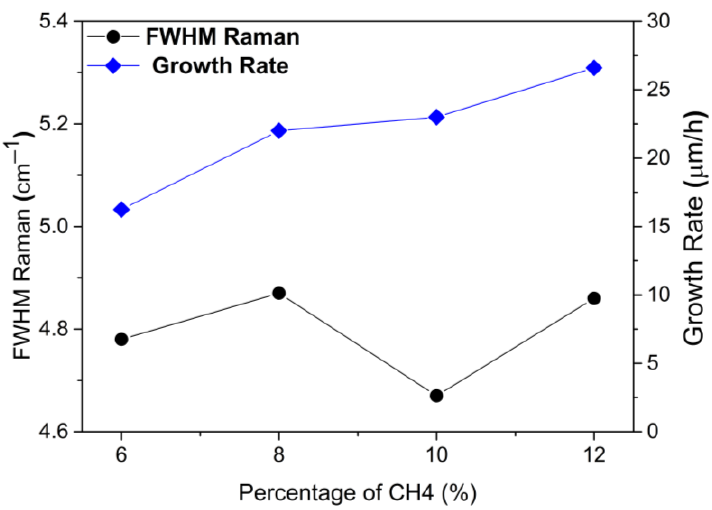
Figure 4. Growth rate and FWHM of the Raman diamond peak as a function of CH 4